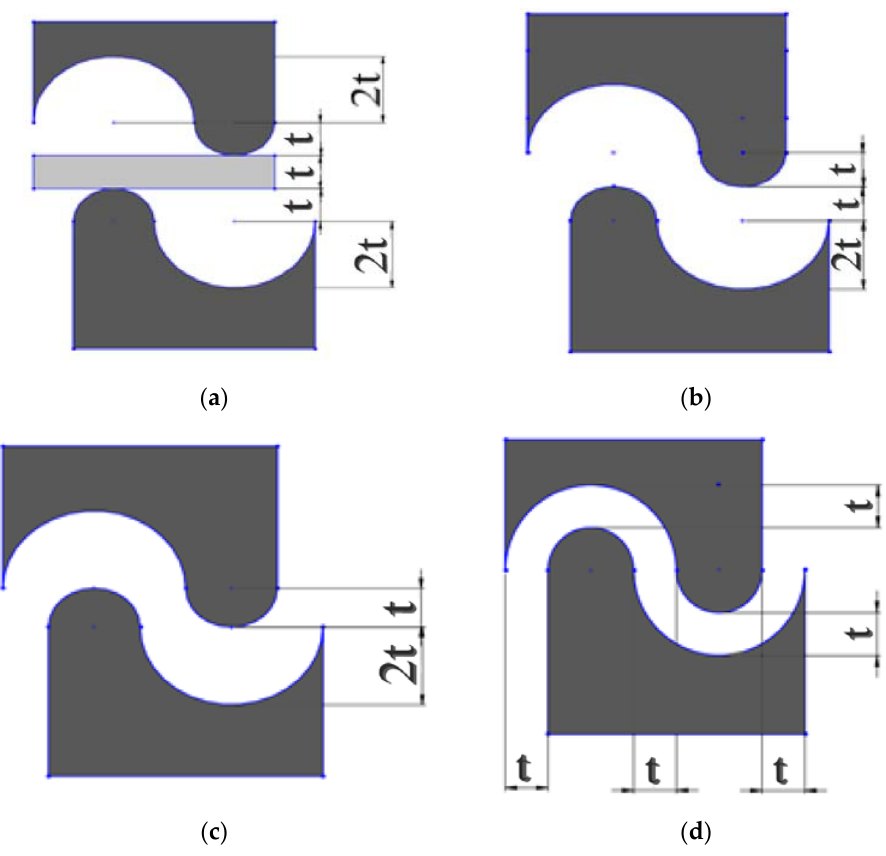
Figure 1. Schematic asymmetric semicircular studs proposed as a modified ‐ CSP method, ( a ) initial contact with the sheet surface, ( b ) moving dies as much as the thickness of the sheet, ( c ) moving dies twice the thickness of the sheet, and ( d ) moving dies three times the thickness of the sheet. (thickness of the sheet is based on millimeters).